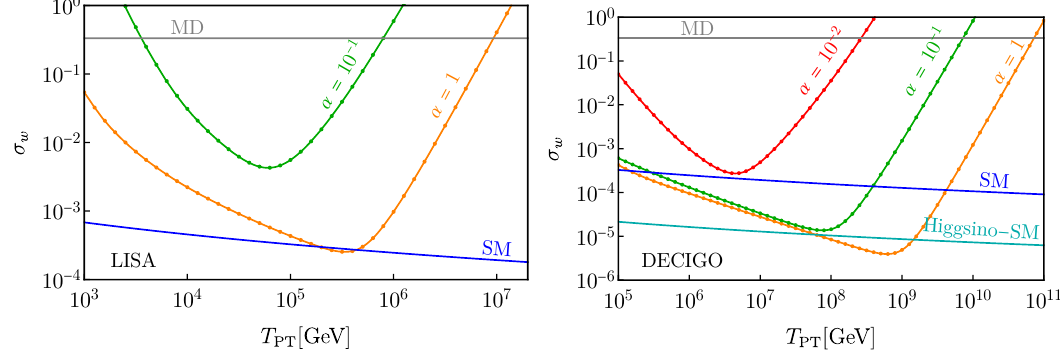
Figure 2 . The projected sensitivity, calculated using the Fisher matrix, of LISA (left) and DECIGO (right) to a constant equation of state near w = 1 / 3 as a function of the temperature at which the phase transition occurred for various α . α controls the amplitude of a GW. For reference we show matter domination ( δw = − 1 / 3 ) as well as the SM and SM plus doublet dark matter predictions for δw versus